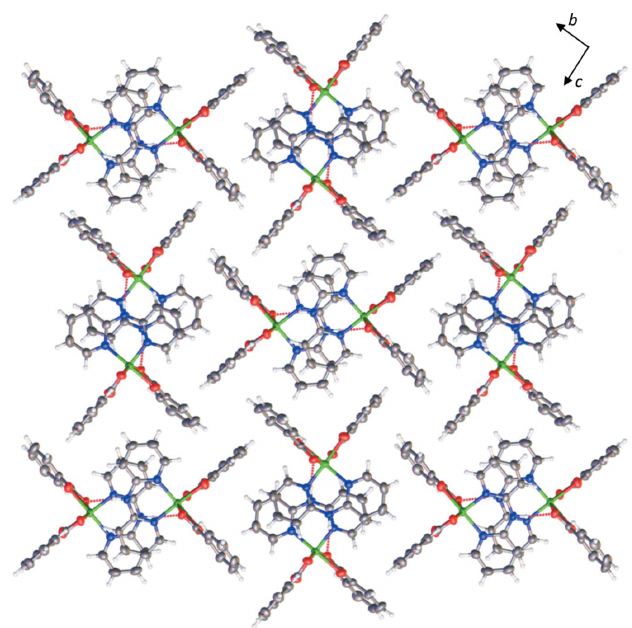
Figure 4 View of the three-dimensional supramolecular network of the title complex.